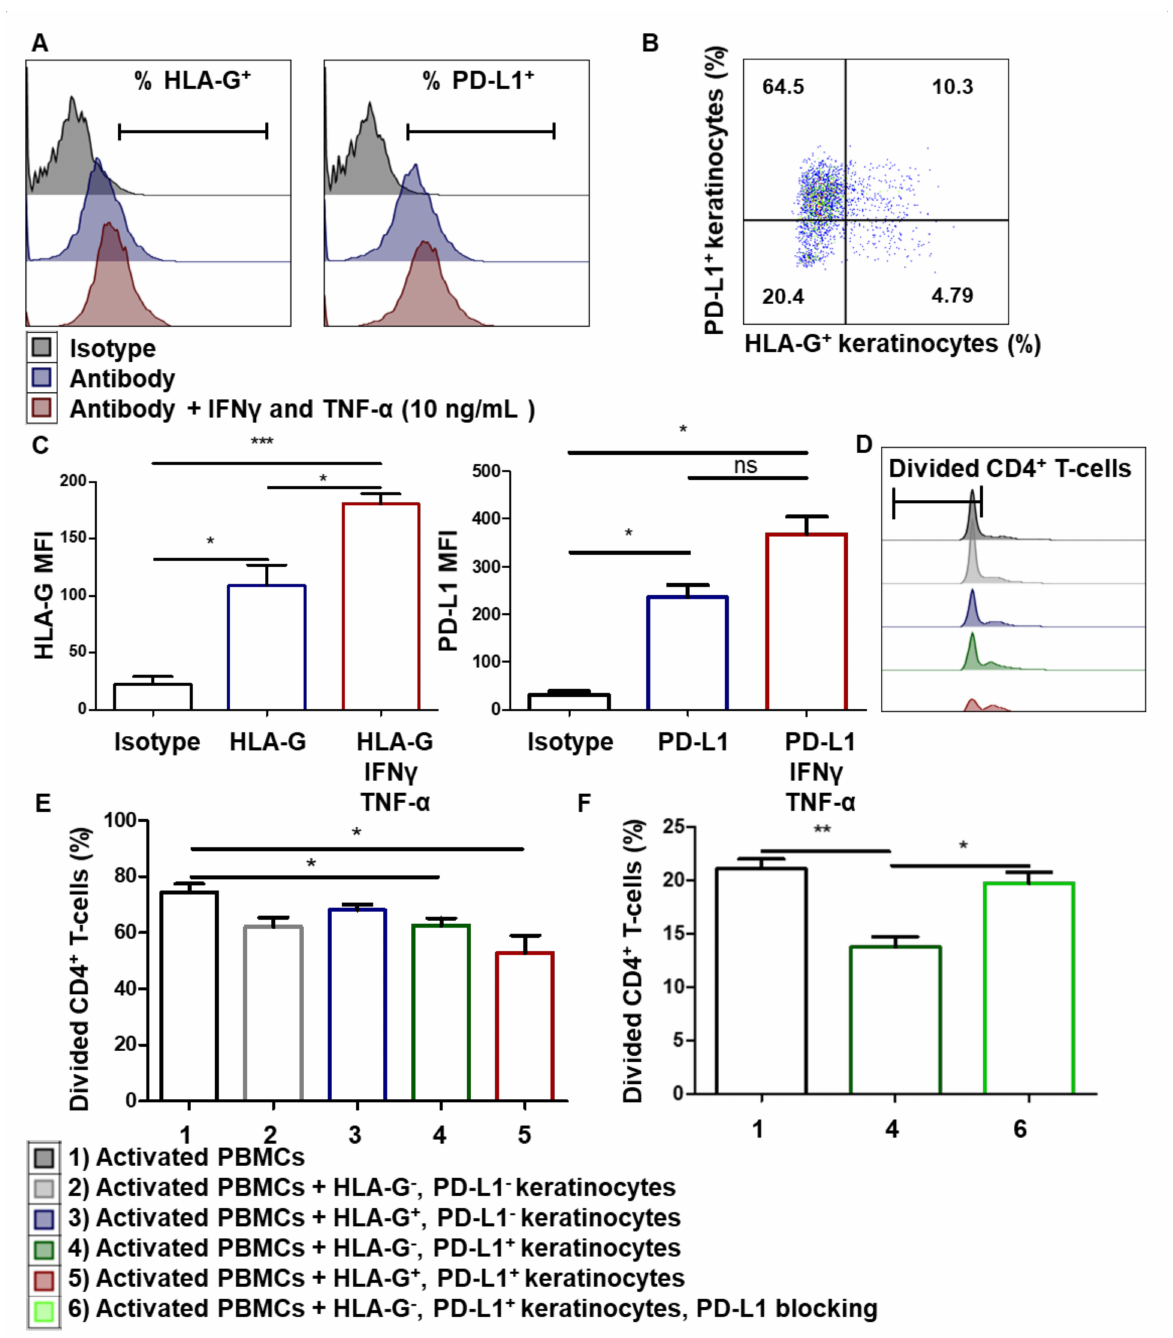
Figure 4. Immunomodulation by amplified keratinocytes involves the PD-L1 immune checkpoint. ( A – C ) Cells from 3 donors were cultured for 2 days with IFN γ and TNF- α . ( A ) Representative flow cytometry profiles at day 2. ( B ) Expression of PD-L1 and HLA-G on keratinocytes. ( C ) Analysis of HLA-G1 (87G) and PD-L1 expression was performed by flow cytometry (mean + SEM, p < 0.05, n = 3). Paired t -test. *: p < 0.05 and **: p < 0.001. ( D – F ) In total, 10,000 keratinocytes sorted as HLA-G − , HLA-G + , PD-L1 − or PD-L1 + were incubated with 100,000 PBMCs for 7 days. PBMCs were activated by CD3 + CD28 + beads. PBMC proliferation was quantified by dye decrease at day 7. ( D ) Representative flow cytometry profiles at day 7. ( E ) CD4 + T-cell proliferation inhibition varied according to the presence of HLA-G or PD-L1 (mean + SEM, p < 0.05, n = 3). ( F ) Effect of PD-L1 blocking. Exact p-values were determined using the t -test. *: p < 0.05 and **: p < 0.01 and ***: p < 0.001, n =